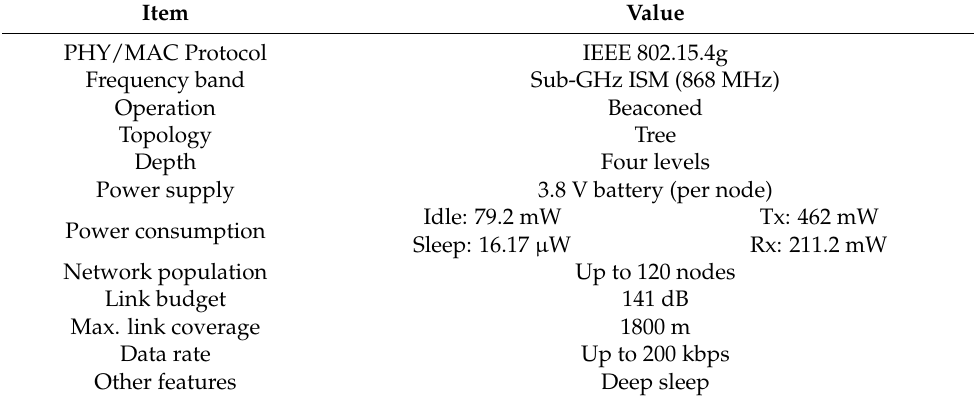
Table 3. Features of the deployed IEEE 802.15.4-based LR-WPANs [9]. Item Value PHY/MAC Protocol IEEE